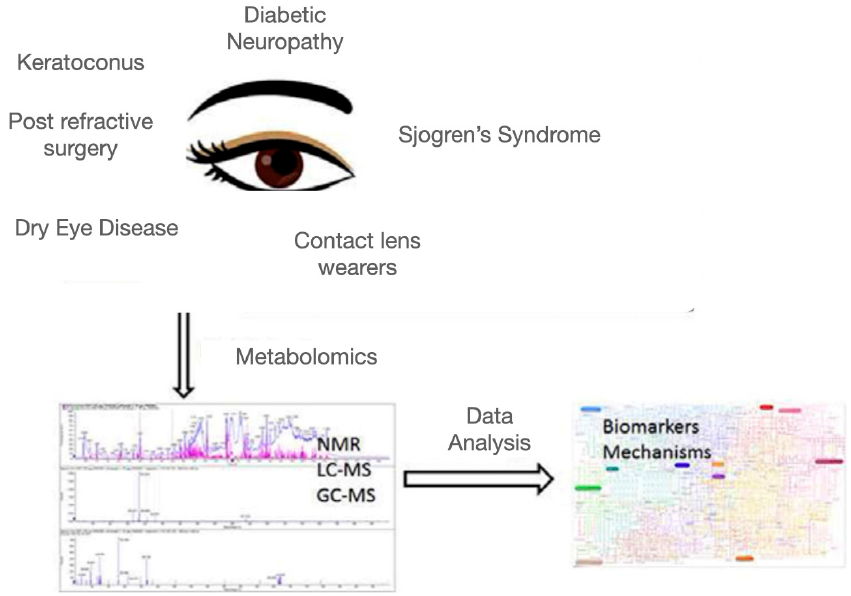
Figure 1. Metabolomics application to corneal diseases to identify new biomarkers or elucidate data for understanding metabolic pathways.